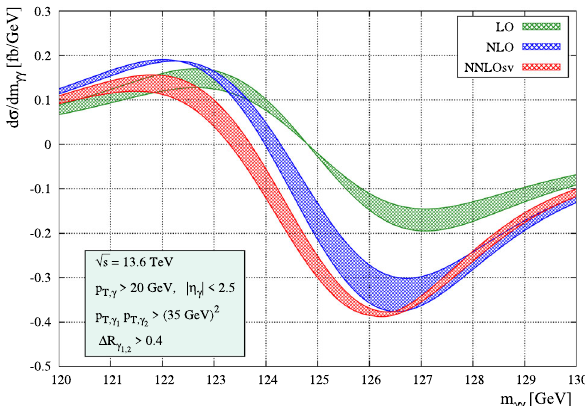
Fig. 4 Signal-background interference contribution to the diphoton invariant mass distribution after Gaussian smearing. Bands